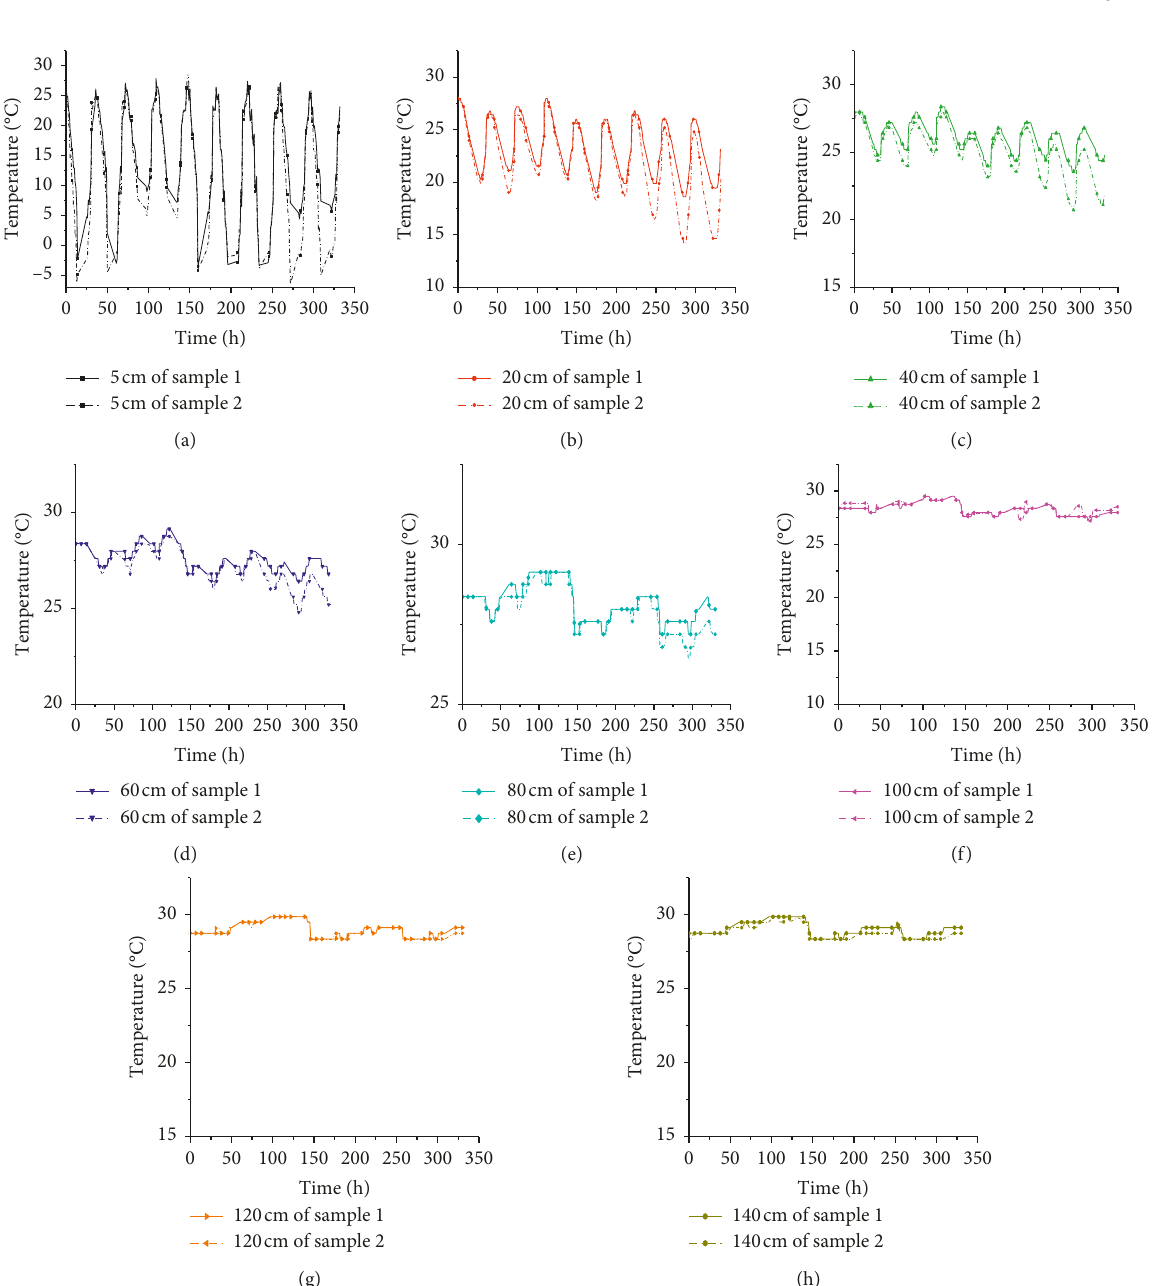
Figure 12: Typical curves of the measured temperature with time for sample 1 of 1.5% salt content and sample 2 of 3% salt